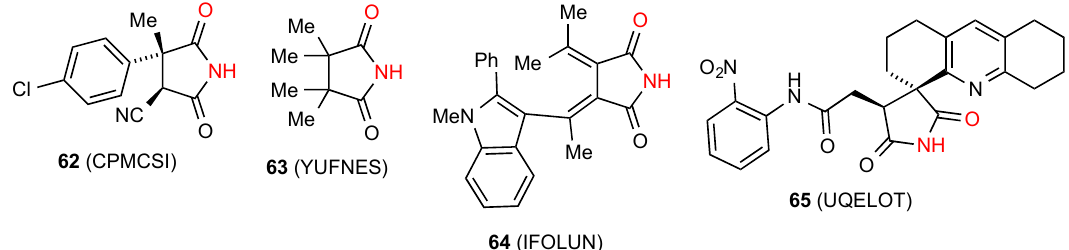
Figure 22. Tri- and tetra-substituted succinimides with patterns A and B.